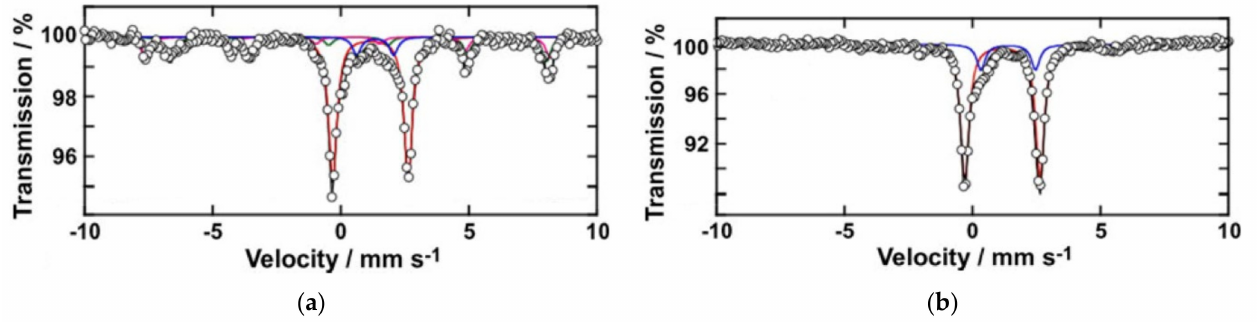
Figure 6. Room temperature Mössbauer spectra of carbonaceous chondrite LEW 86258 CK3 ( a ) and R chondrite LAP 03834 R3 ( b ). Indicated components are the results of the fits. Adapted from Reference